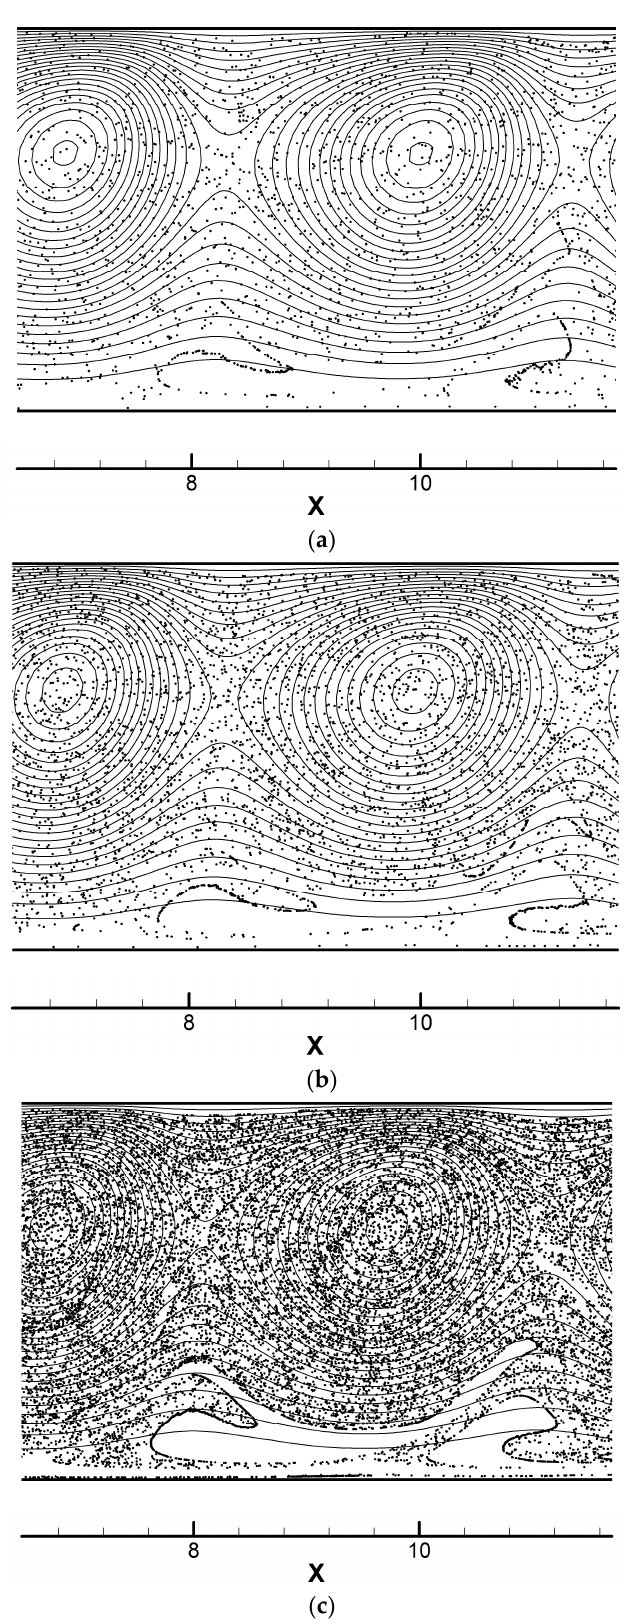
Figure 5. Distribution of particles (detail) for χ = 0.7 and different values of the Stokes number: ( a ) St = 10 − 5 , ( b ) St = 5 × 10 − 6 , and ( c ) St = 10 − 6 (the vertical extension is not to scale).